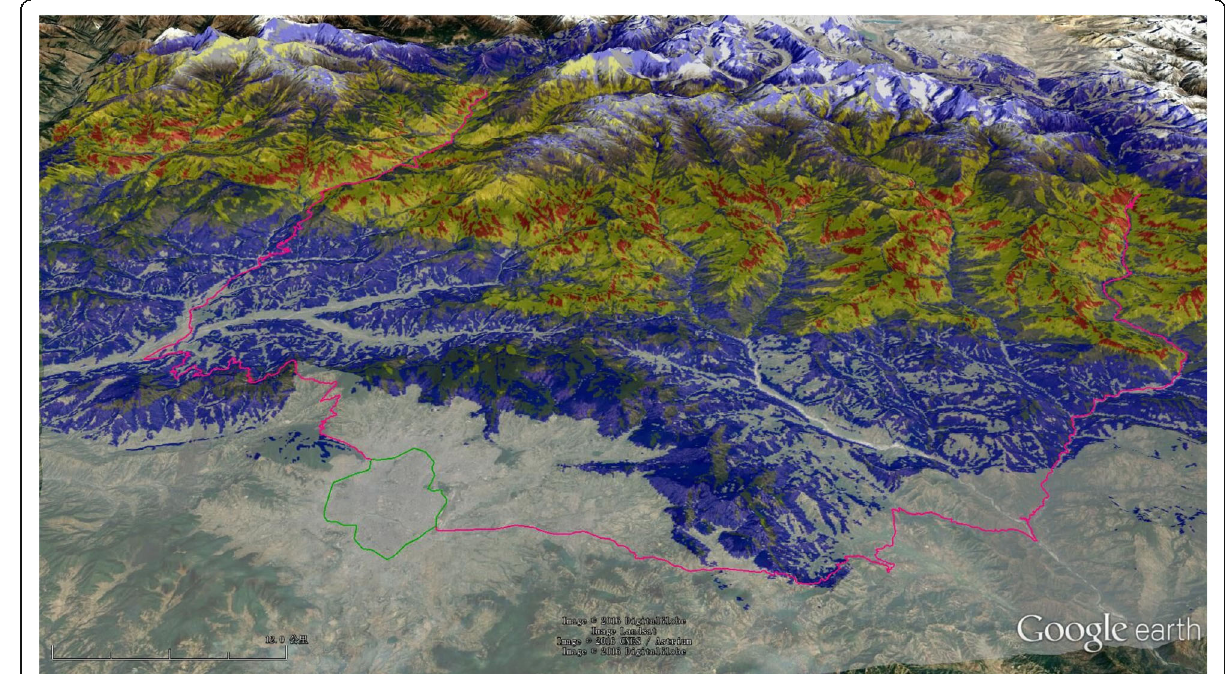
Fig. 17 A printing screen showing a three-dimensional perspective on the landslide hazard map. View to